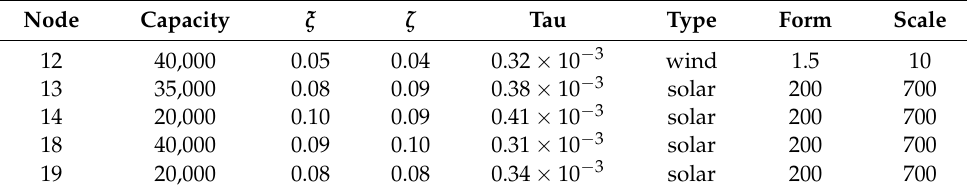
Table A3. Converter